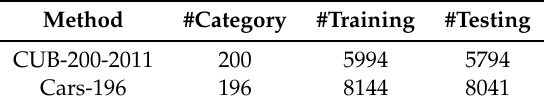
Table 1. Statistics of used fine-grained